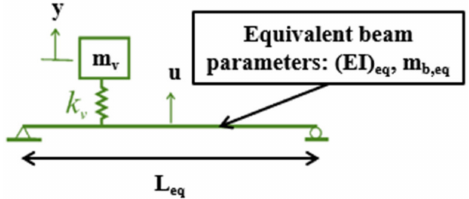
Figure 8. Sprung mass model (modified from